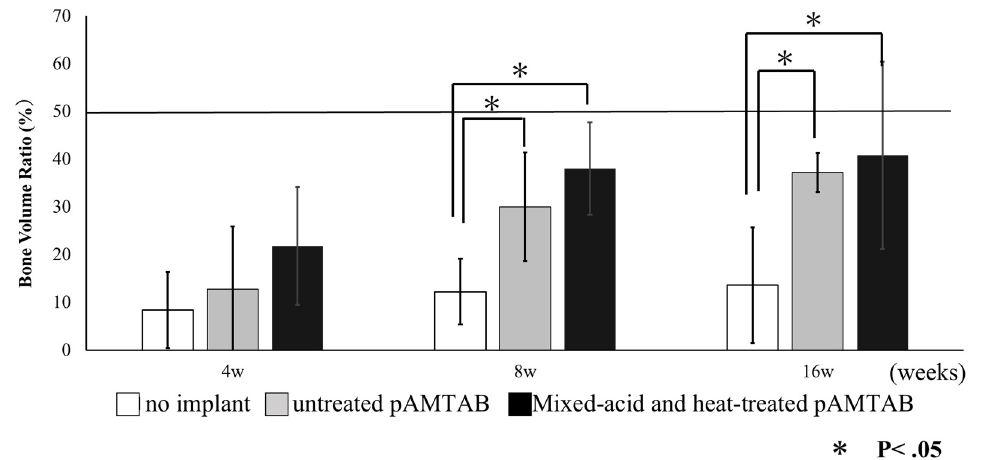
Figure 7. Bone volume ratio in all experimental groups. At 4 weeks, no significant difference is found among the three groups, but at 8 and 16 weeks, bone formation is significantly greater in the untreated porous additive-manufacturing titanium artificial bone (pAMTAB) group and mixed-acid and heat-treated pAMTAB group than in the no implant control group. The data for each group were analyzed by one-way analysis of variance and Tukey’s multiple comparison test using JMP ® software (SAS Institute Inc., Cary, NC, USA). p values < 0.05 were considered significant.